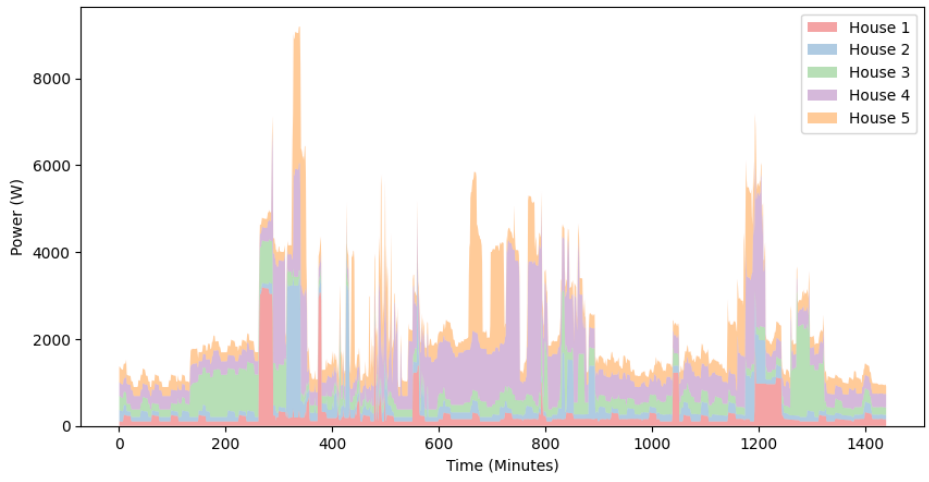
Figure 5. First day of the community consumption profile.